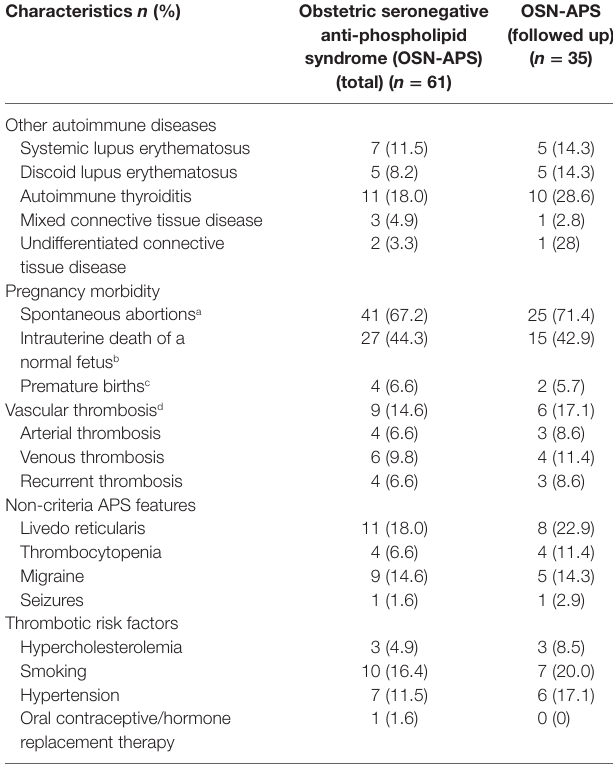
Table 1 | Clinical characteristics of patients studied. characteristics n